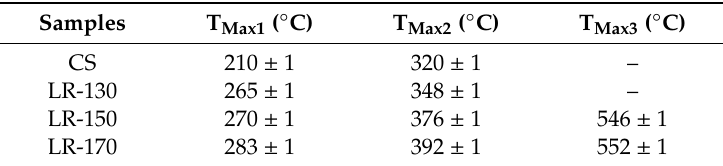
Figure 4. TG ( a ) and DTG ( b ) curves of CS and LRs. Table 1. The main weight-loss stage of CS and LRs in the DTG curves.